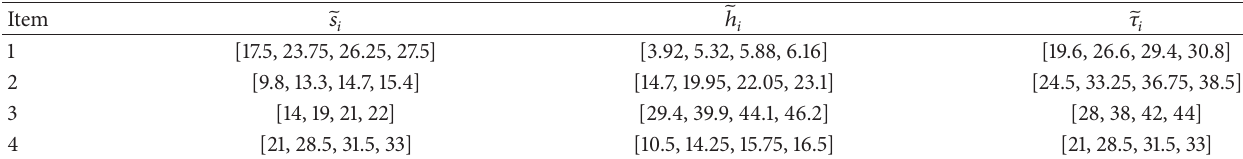
Table 5: The basic data after extension.